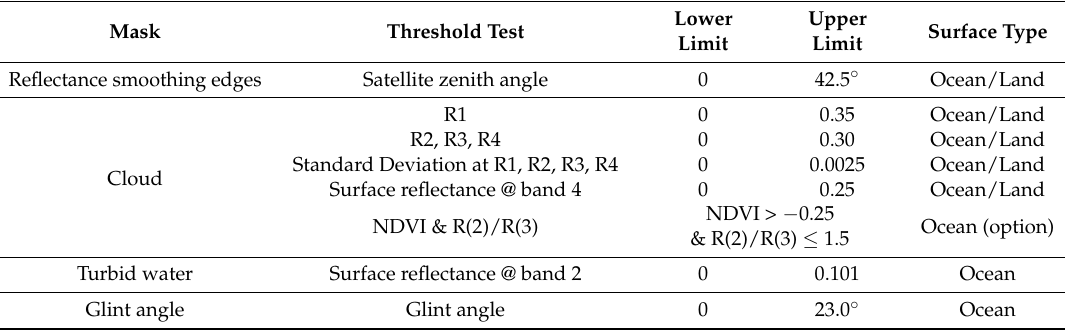
Table 4. Mask of reflectance smoothing edges, cloud, turbid, and glint